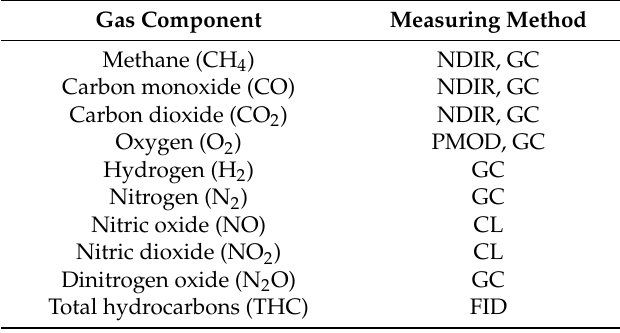
Table 2. Overview of measured gas components and instrumentation. NDIR = Non-Dispersive Infrared Sensor, GC = Gas Chromatography, PMOD = paramagnetic oxygen detector, CL = Chemiluminescence, FID = Flame Ionization